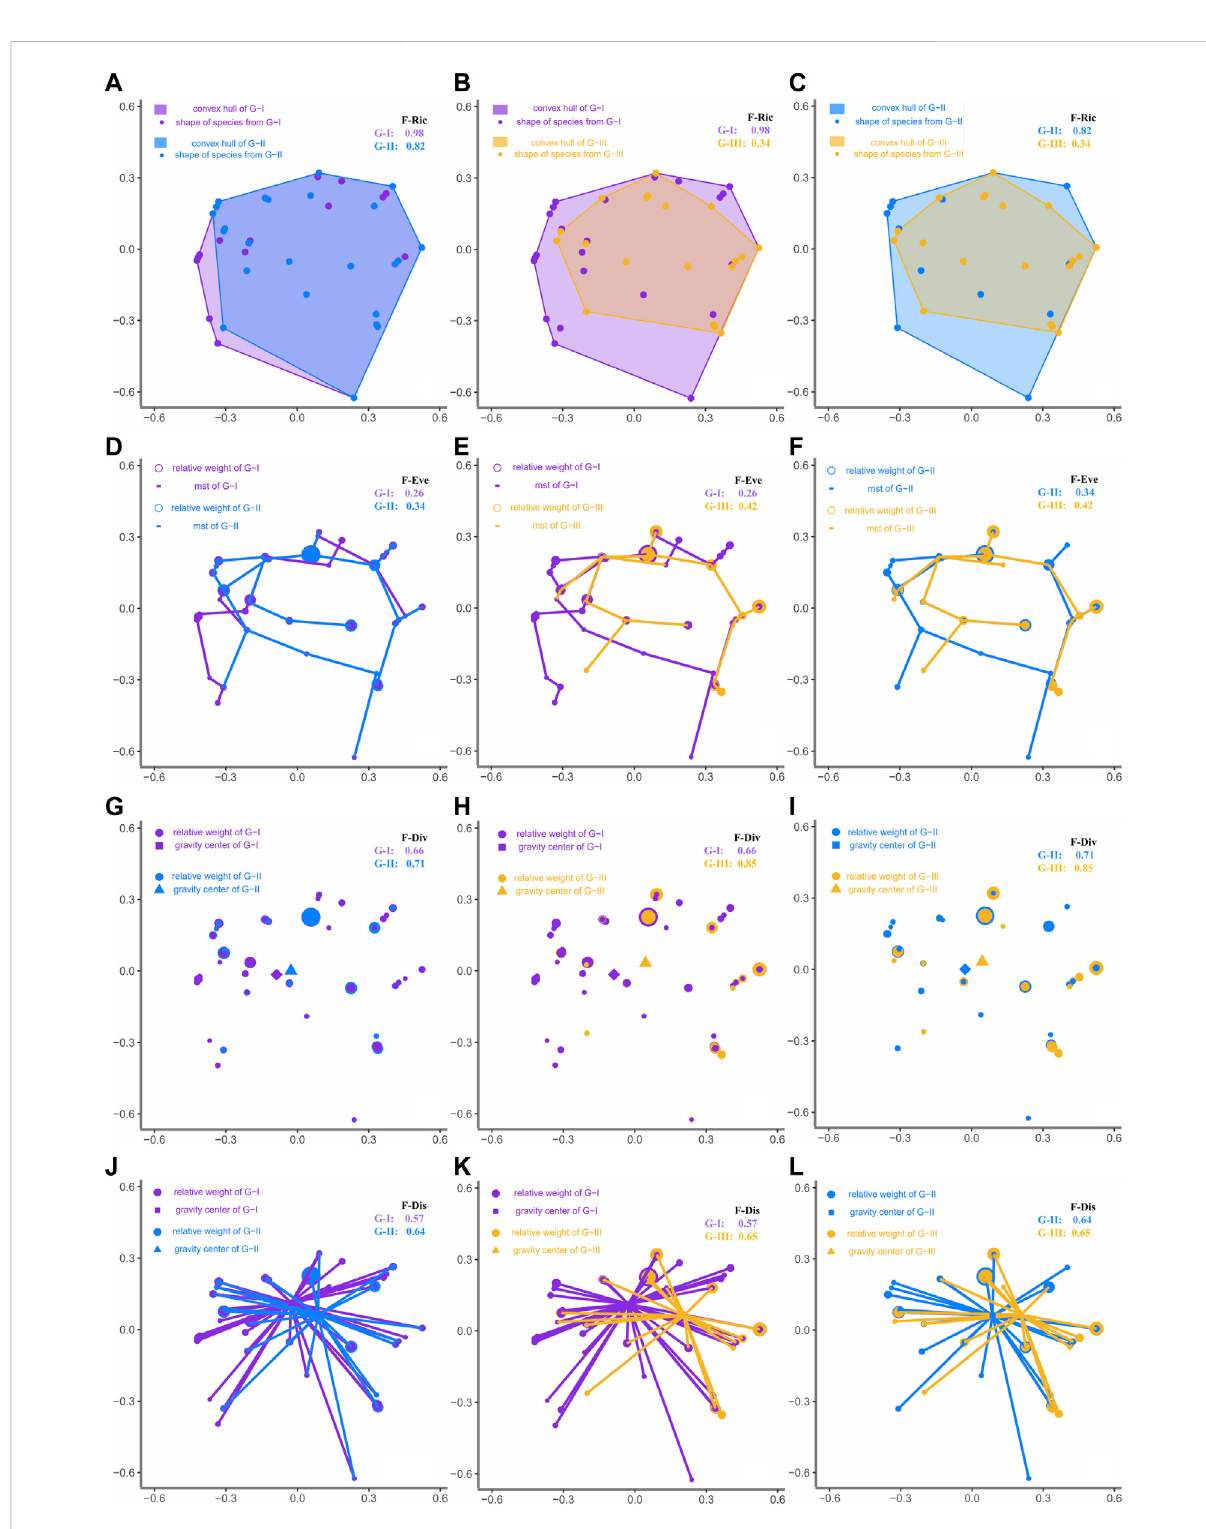
FIGURE 8 Calculation of the functional indices in the multidimensional functional space for fi sh species of each spatial water quality group (G-I, G-II, and G-III) (A – C) for F-Ric - the volume of a convex hull formed by species positions along trait-based PCoA coordinates, (D – F) for F-Eve - the regularity of species positions and abundance along the minimum spanning tree (mst) in functional space (G – I) for F-Div - the deviation in the proportion of total abundance supported by the species with the most extreme traits, (J,K) for F-Dis - the average abundance-weighted species distance from the centre of gravity in functional space. (L) Functional indices compared between the groups (G-I and G-II, G-I and G-III, G-II and